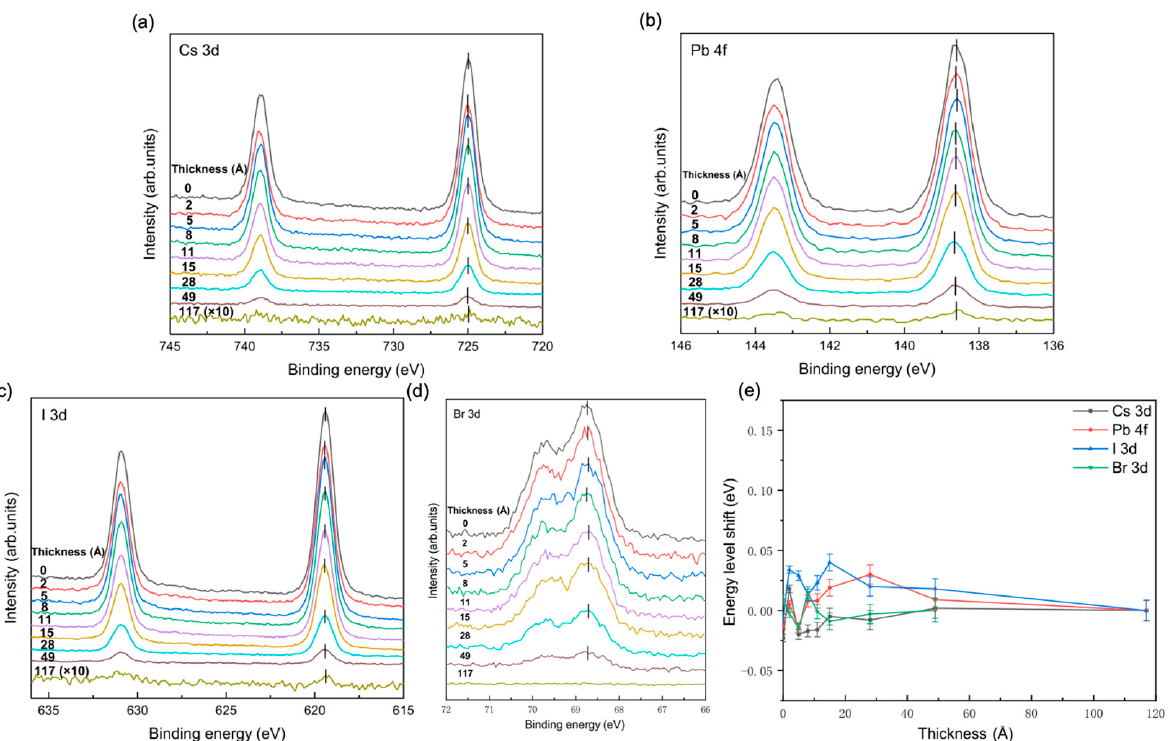
this side of the CuPc/CsPbI 2 Br interface.